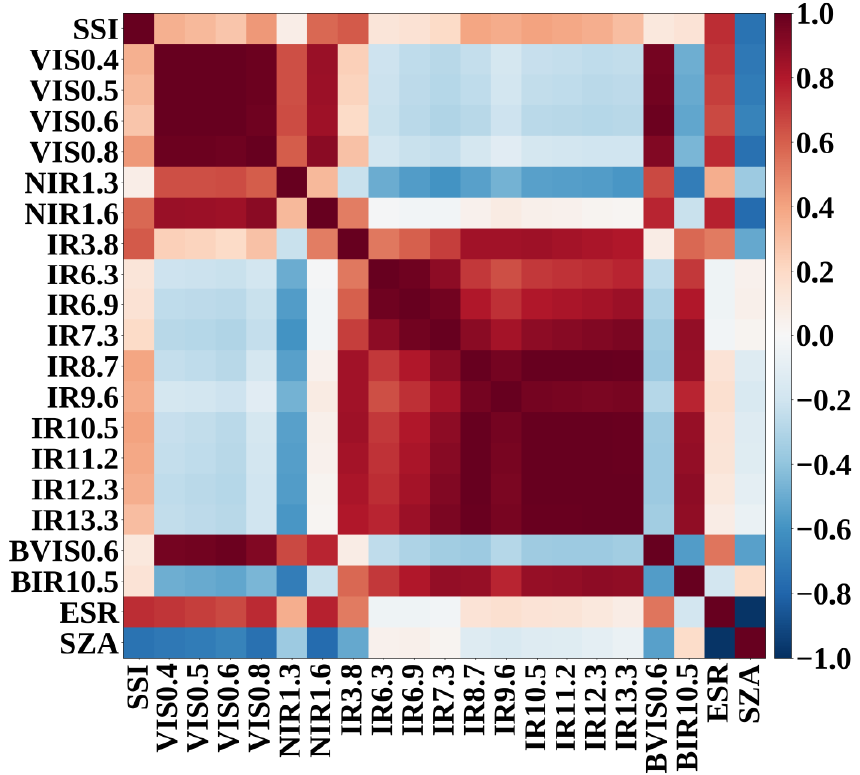
Figure 4. Correlation matrix of the input variables in different datasets for the period from 25 July 2019 to 31 July 2020, where BVIS0.6 and BIR10.5 indicate the background channel at 0.6 μm and 10.5 μm, respectively.